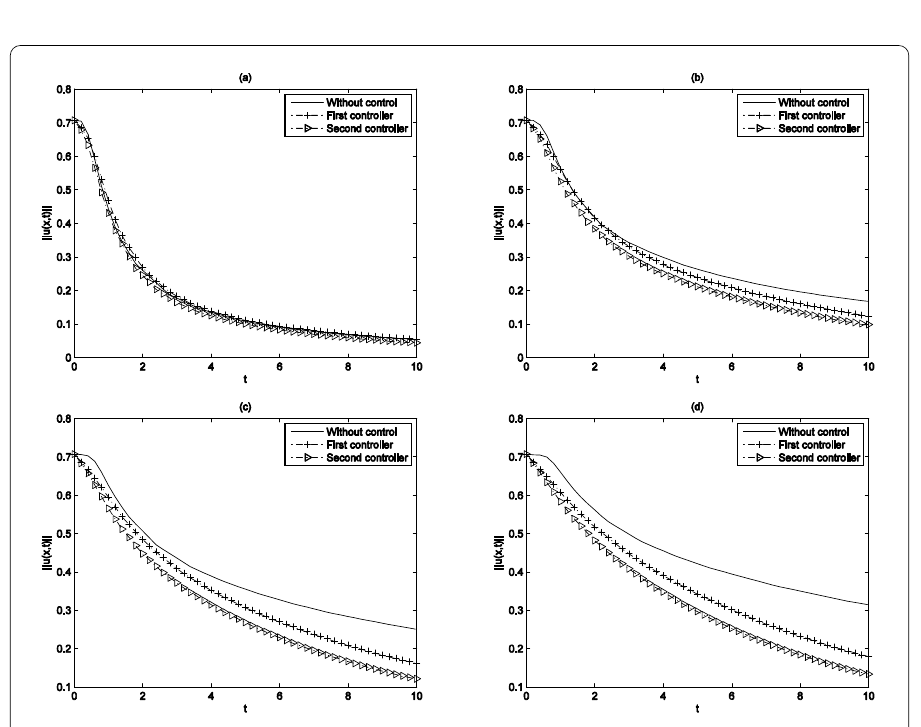
Figure 19 The L 2 -norm of u ( x , t ), (cid:7) u ( x , t ) (cid:7) , versus time for different values of α ; comparison between the behavior of the equation with and without control when v = 0.01, μ = 0.001, γ 1 = 1, γ 2 = 0.0005 and u 0 ( x ) = sin( π x ); ( a ) α = 1; ( b ) α = 2; ( c ) α = 3; ( d ) α = 4